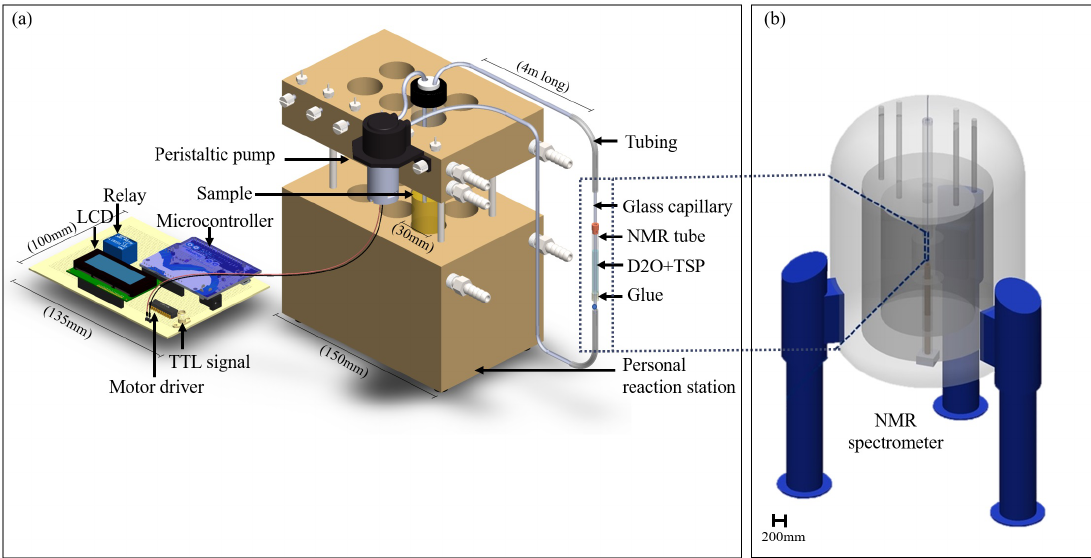
Figure 2. ( a ) Experimental setup. The bioreaction is performed using the personal reaction station (PRS). A peristaltic pump is mounted on the PRS to flow the sample periodically through the capillary-based flow cell (inside the NMR magnet) for NMR measurement and subsequently return it to the bioreactor. The peristaltic pump is controlled by a microcontroller using a relay and a motor driver, with a liquid crystal display (LCD) used to display the time to the user. A TTL (transistor-transistor logic)signal is sent to the NMR spectrometer after the sample has been transferred to the NMR detector to initiate measurement. Note: tubing length not to scale. ( b ) NMR spectrometer with flow-through capillary system in the